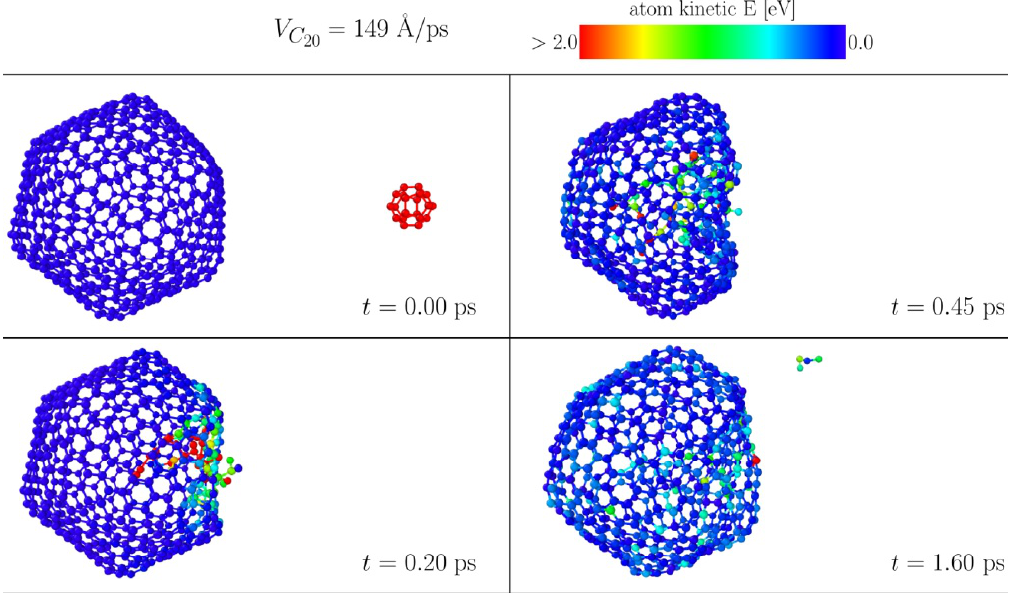
Fig. 8. Snapshots of the fullerene collision at the initial velocity V fullerene takes place with the formation of smaller carbon